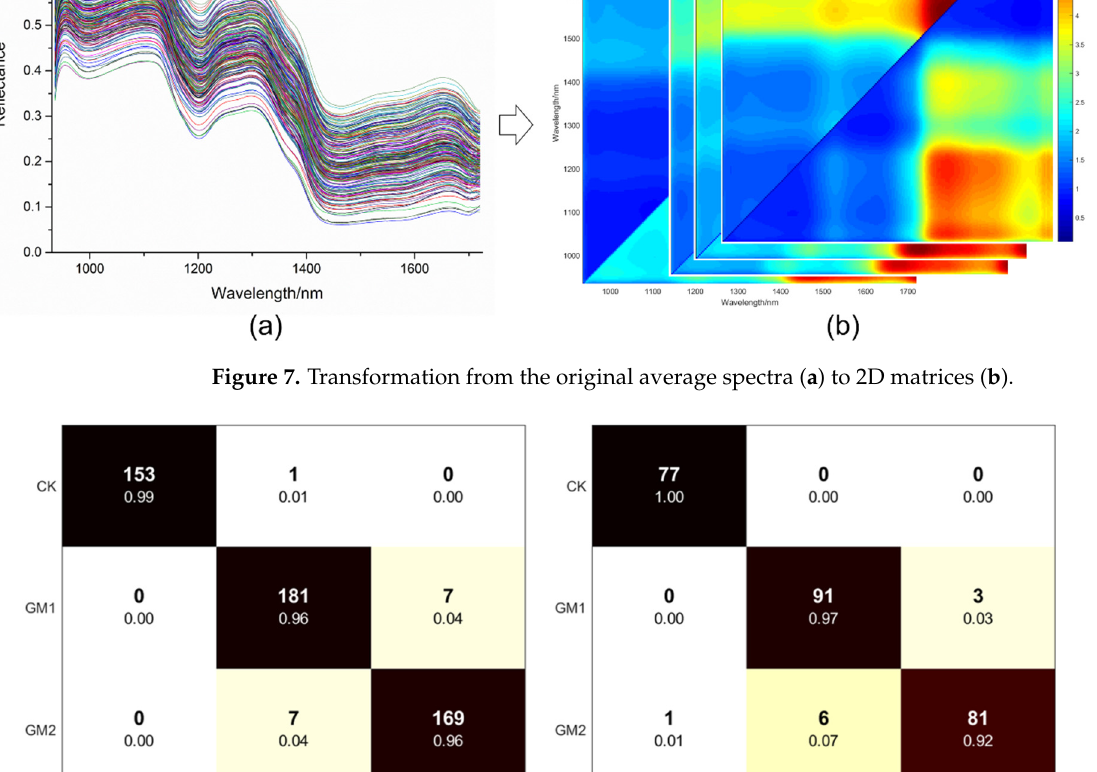
Figure 8. Confusion matrices of the training set ( a ) and the prediction set ( b ) for the VGG-dilated model established by 2D spectral